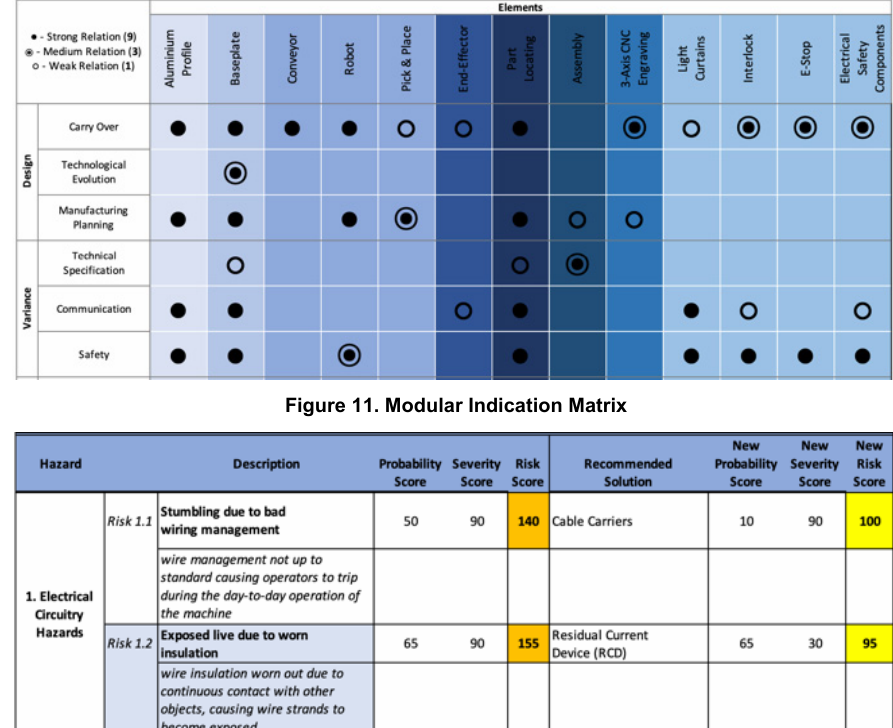
Figure 12. Updated Risk